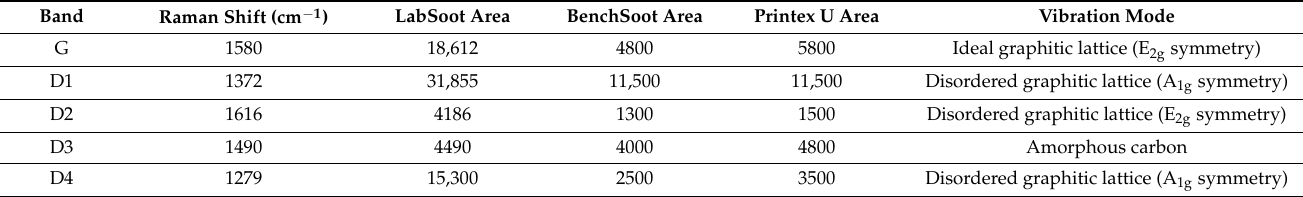
Table 1. Raman signal contributions for the different samples of